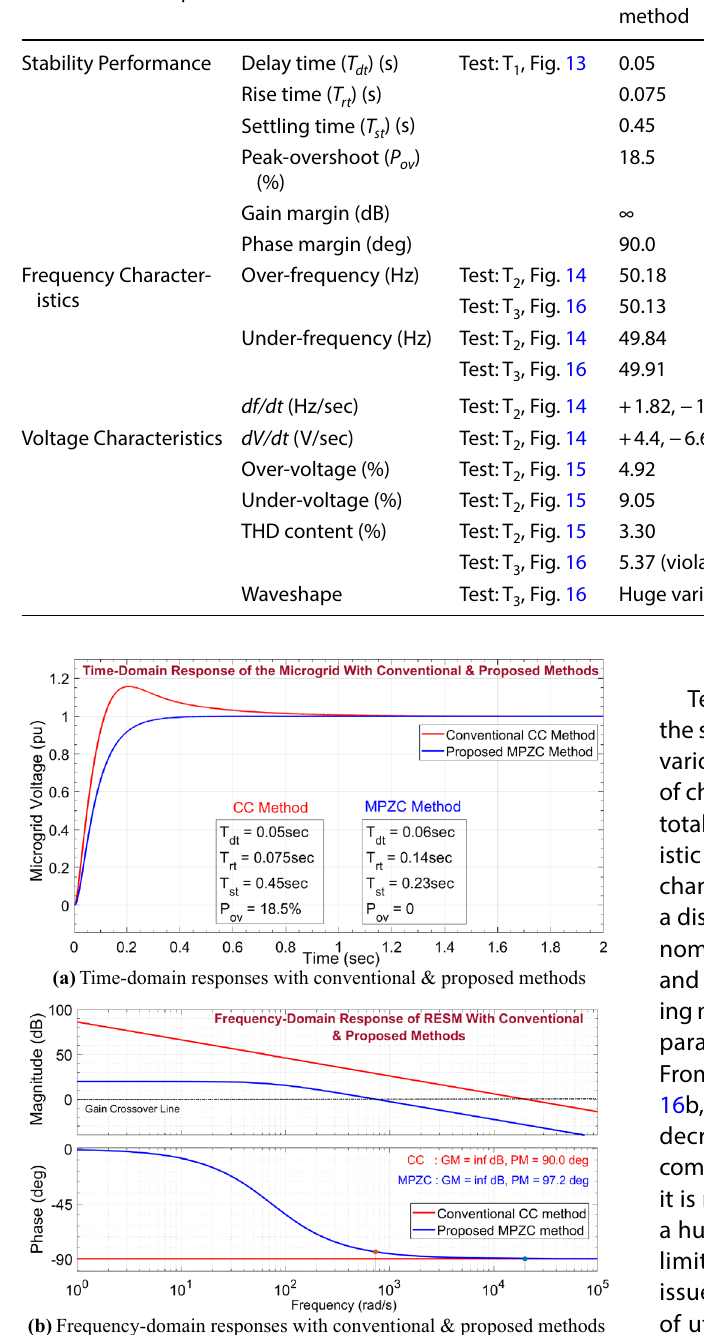
Fig. 13 Voltage responses of the RESM as per test case-T